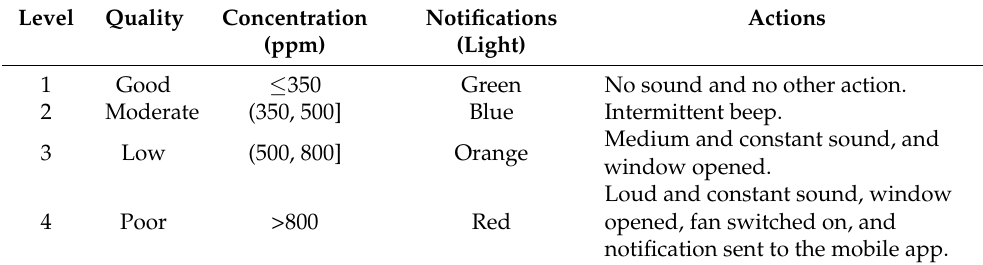
Table 1. Air quality levels